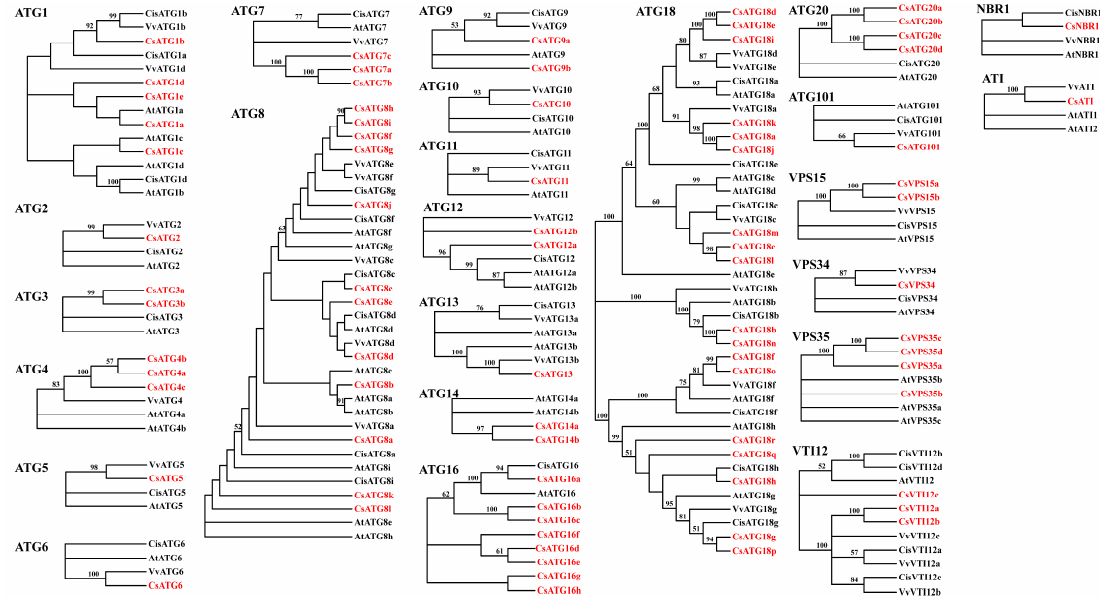
Figure 2. Phylogenetic analysis of Camellia sinensis and other plant ATG proteins. The neighbor-joining trees were constructed with 80 CsATGs of Camellia sinensis (Cs), 49 AtATGs of Arabidopsis thaliana (At), 37 CisATGs of Citrus sinensis (Cis) and 35 VvATGs of Vitis vinifera (Vv) using the MEGA-X software, with 1000 bootstrap replicates, and displayed without the tree root using the online tool iTOL (https://itol.embl.de/). The genes of tea plant are marked in red color. The bootstrap values higher than 50% are shown in the phylogenetic trees.